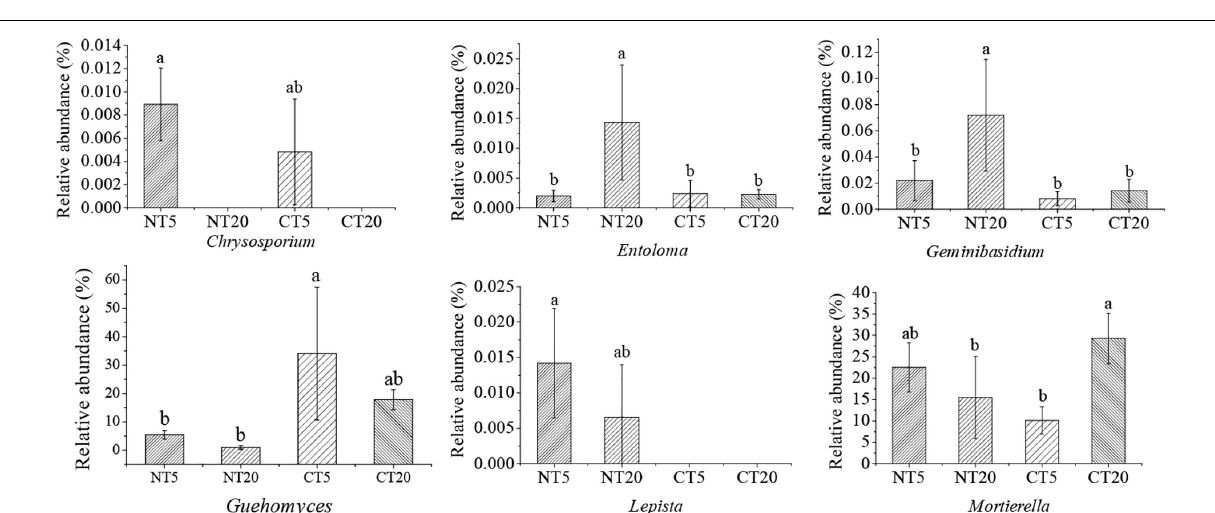
present study have been proven to have different